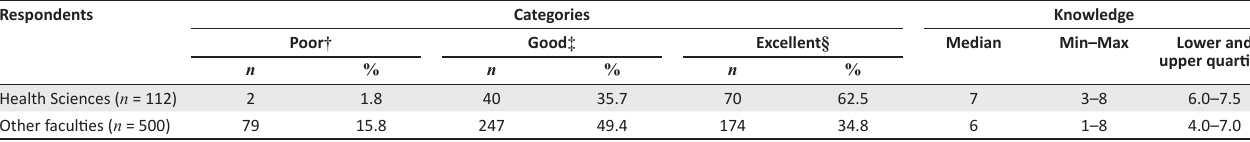
TABLE 3: Respondents’ knowledge categories of family history of hereditary diseases ( n = 612).